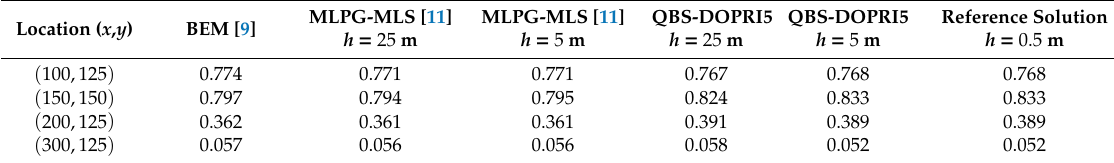
Table 6. Comparison of concentration values obtained by QBS-DOPRI5 with other numerical methods at time t = 200 days (Scenario